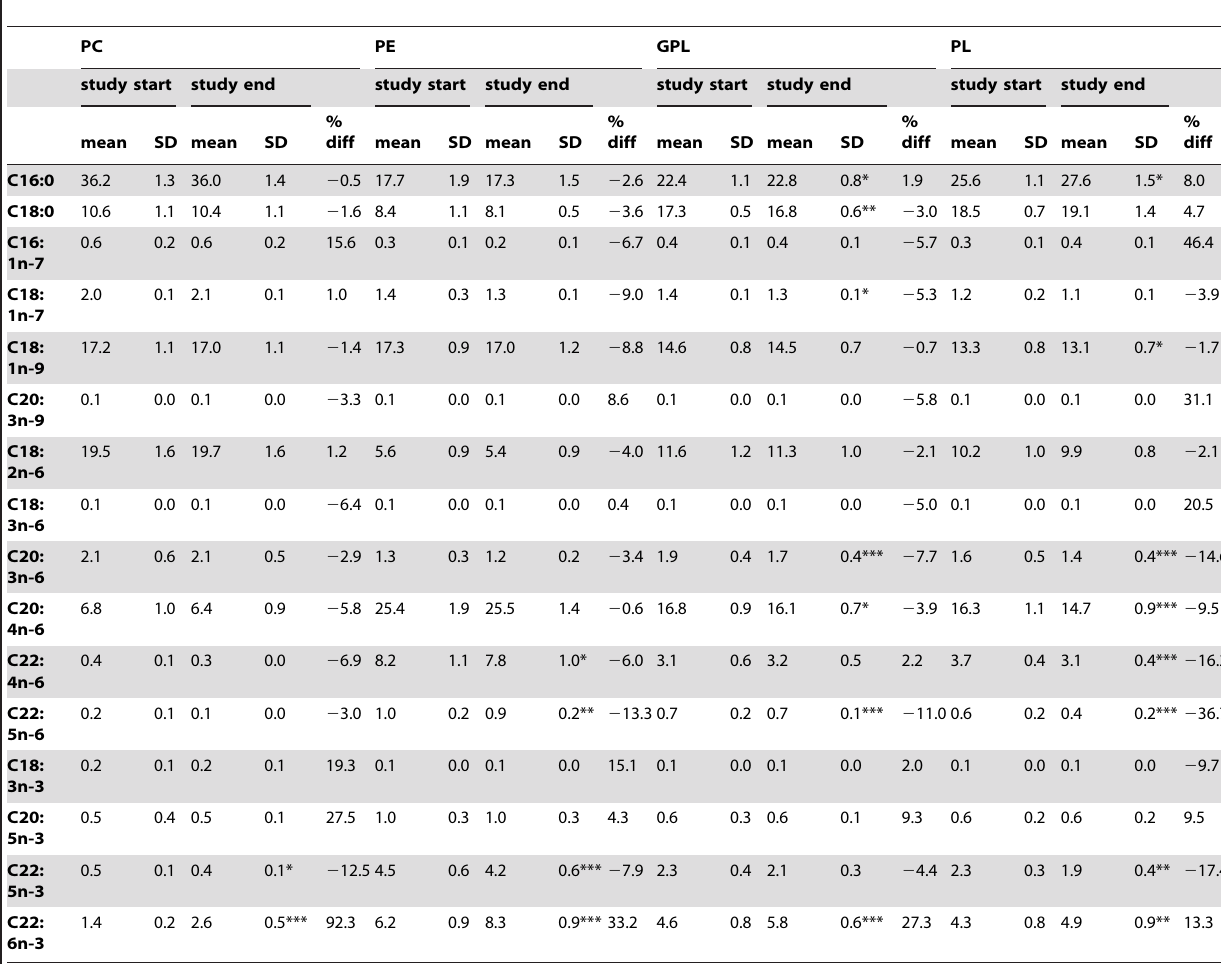
Table 3. Effects of DHA supplementation on fatty acid composition (%wt/wt) of individual RBC PL fractions.